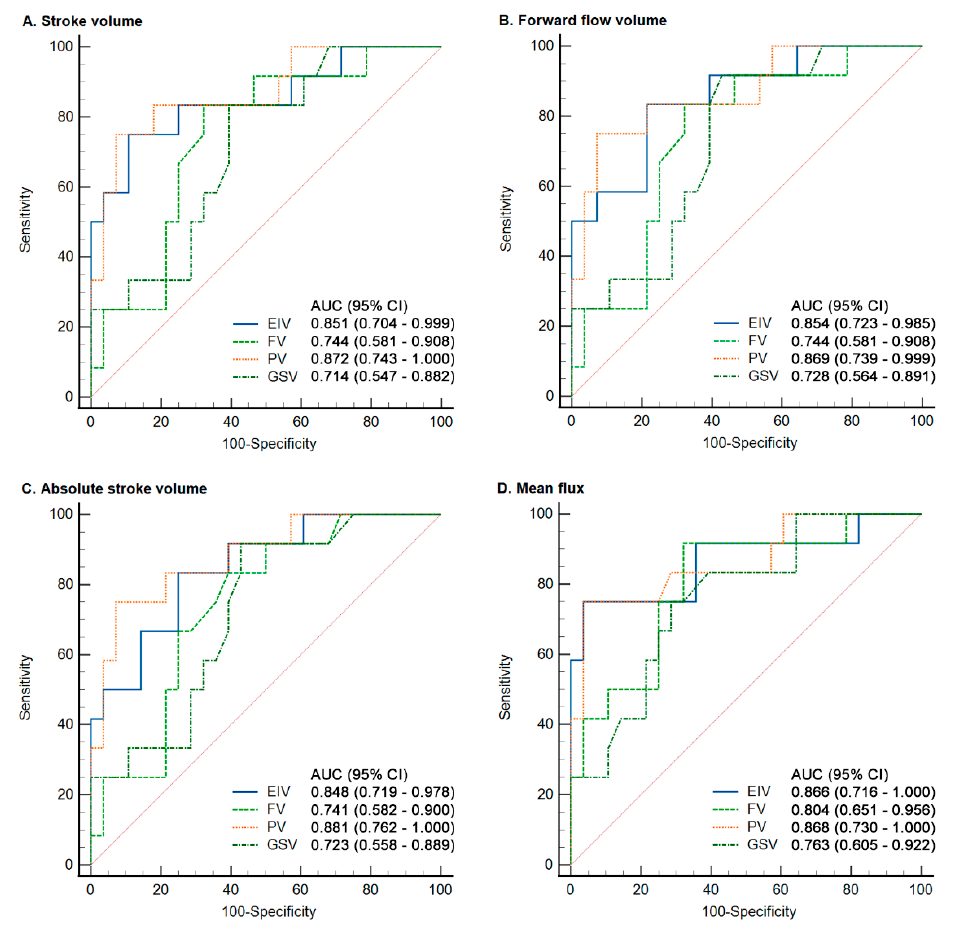
Figure 5. ROC curve of the SV, FFV, ASV, and MF of the QFlow analysis.